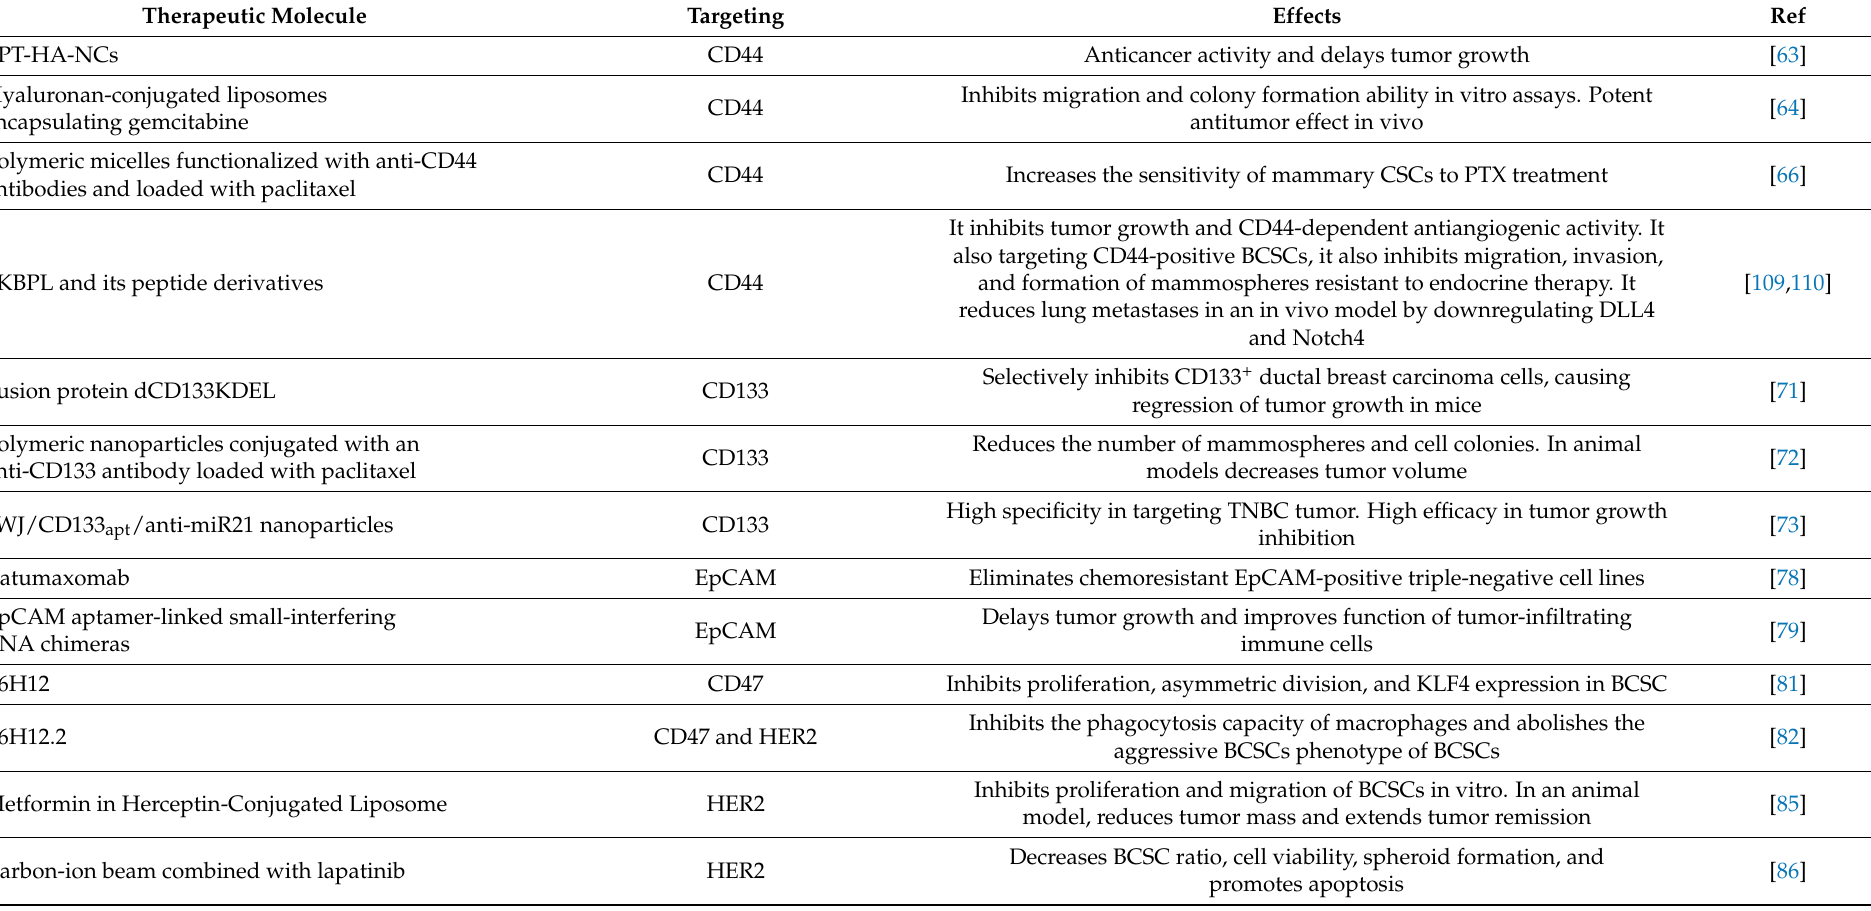
Table 1. Preclinical studies of therapeutic compounds directed against breast cancer stem-like